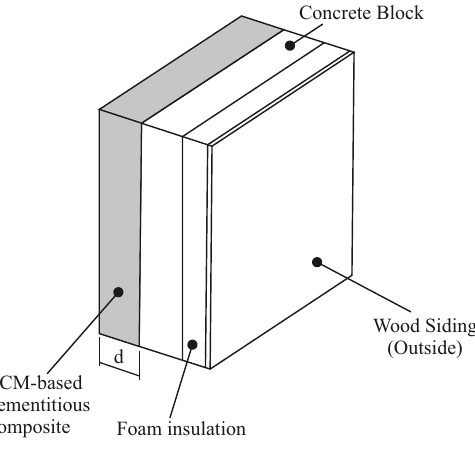
Figure 2. Wall material